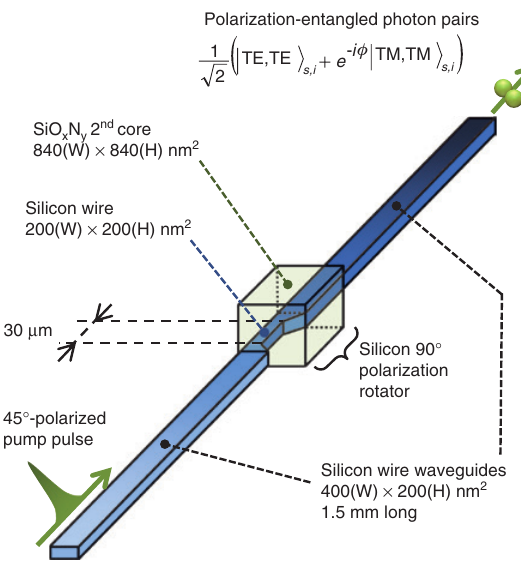
Figure 2: A polarization entangled photon pair source fabricated on a silicon-on-insulator